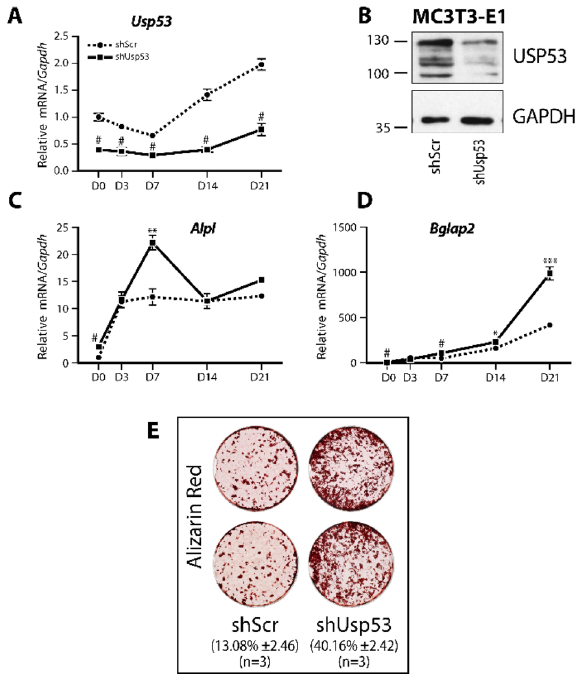
Figure 6. Usp53 knockdown enhances the differentiation of committed osteoblasts. ( A , C , D ) Knockdown of Usp53 in MC3T3-E1 cells and gene expression analysis of osteogenic differentiation markers. Quantitative RT-qPCR using probes against Usp53 , Alpl , and Bglap2 , normalized to Gapdh , was performed on RNA isolated from shScr-stably transfected (dashed line) or shUsp53-stably transfected (solid line) pools of MC3T3-E1 cells differentiated for 21 days in osteogenic medium. ( B ) Western blot analysis of Usp53 expression. Total protein isolated from MC3T3-E1 cells stably transfected with shScr or shUsp53 at D1, confirming the knockdown of Usp53 . GAPDH was used as a loading control. Full-length blots are presented in Supplementary Figure S7. ( E ) MC3T3-E1 cultures were examined for calcium deposition using alizarin red staining at D21. Results are presented as the mean fold change ± SD. * P ≤ 0.05; ** P ≤ 0.01; *** P ≤ 0.001; # P < 0.0001; ANOVA with Bonferroni’s post-hoc test for all